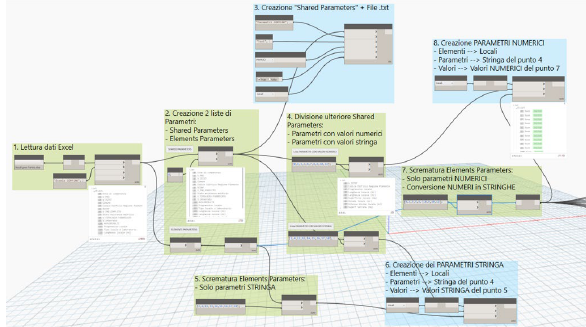
Figure 6. The entire pipeline of Dynamo script related to the EDISCO school